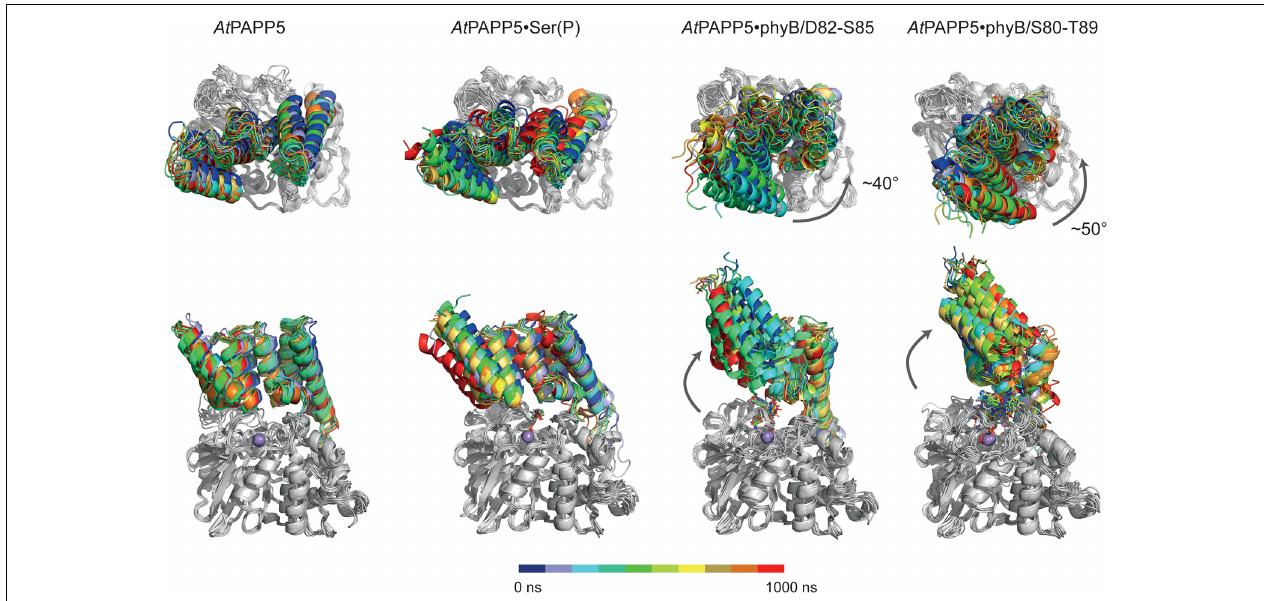
FIGURE 7 | MD simulation of At PAPP5 and its complexes to phosphorylated phyB peptides. Ten snapshots of a representative 1 µ s trajectory are shown with the PP2A domains superposed on each other to highlight displacements of the TPR region. The upper row shows a view mostly along the linker helix between the TPR region and PP2A domain; here a counter-clockwise movement of the TPR region relative to the PP2A domain is apparent upon binding of phyB peptides. The lower row depicts a perpendicular view and shows partial off-swiveling of the TPR region to open up the peptide-binding channel of At PAPP5.